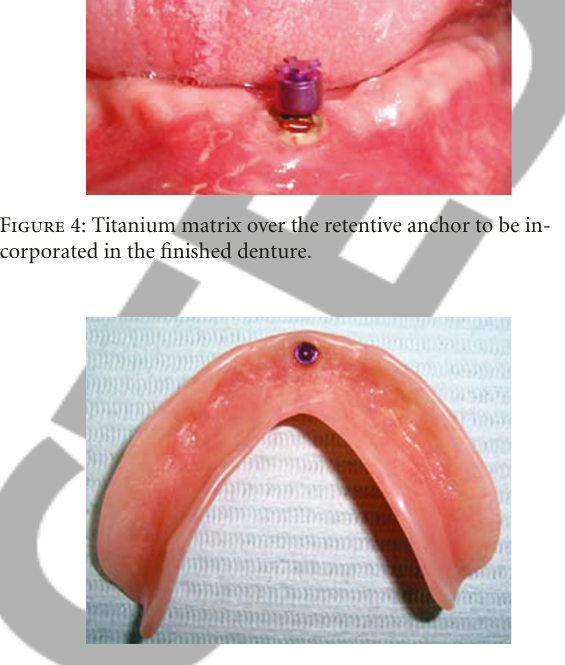
Figure 5: Finished mandibular overdenture with titanium matrix immediately before